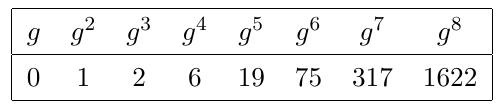
Table 3 . Number of topologically distinct 1PI 2-pt diagrams without